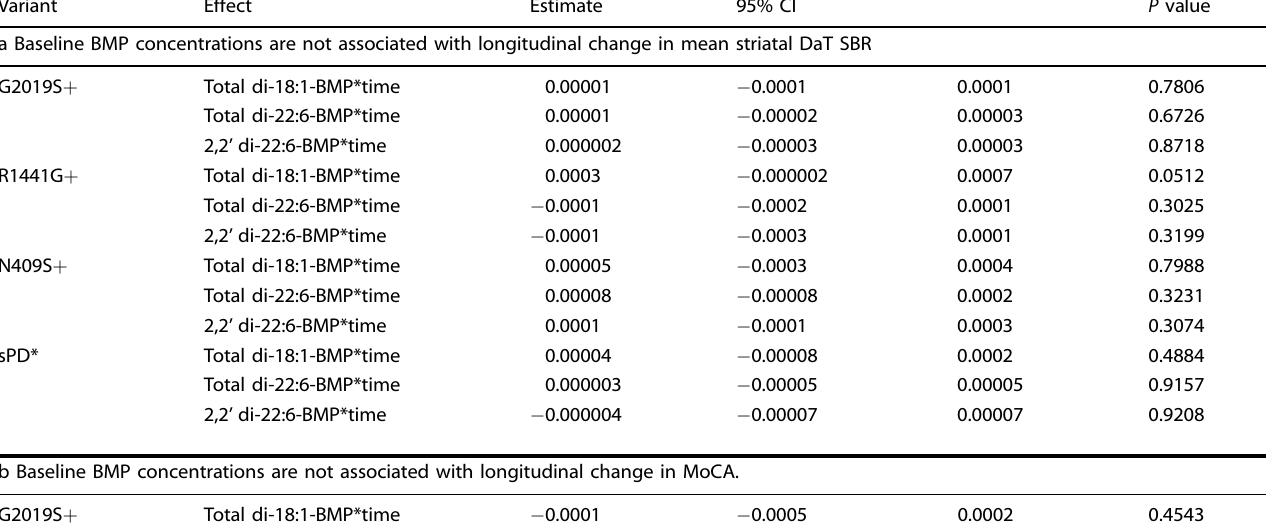
Table 4. Examination of an association between baseline BMP concentrations and longitudinal changes in DaT, MoCA or MDS-UPDRS III off.